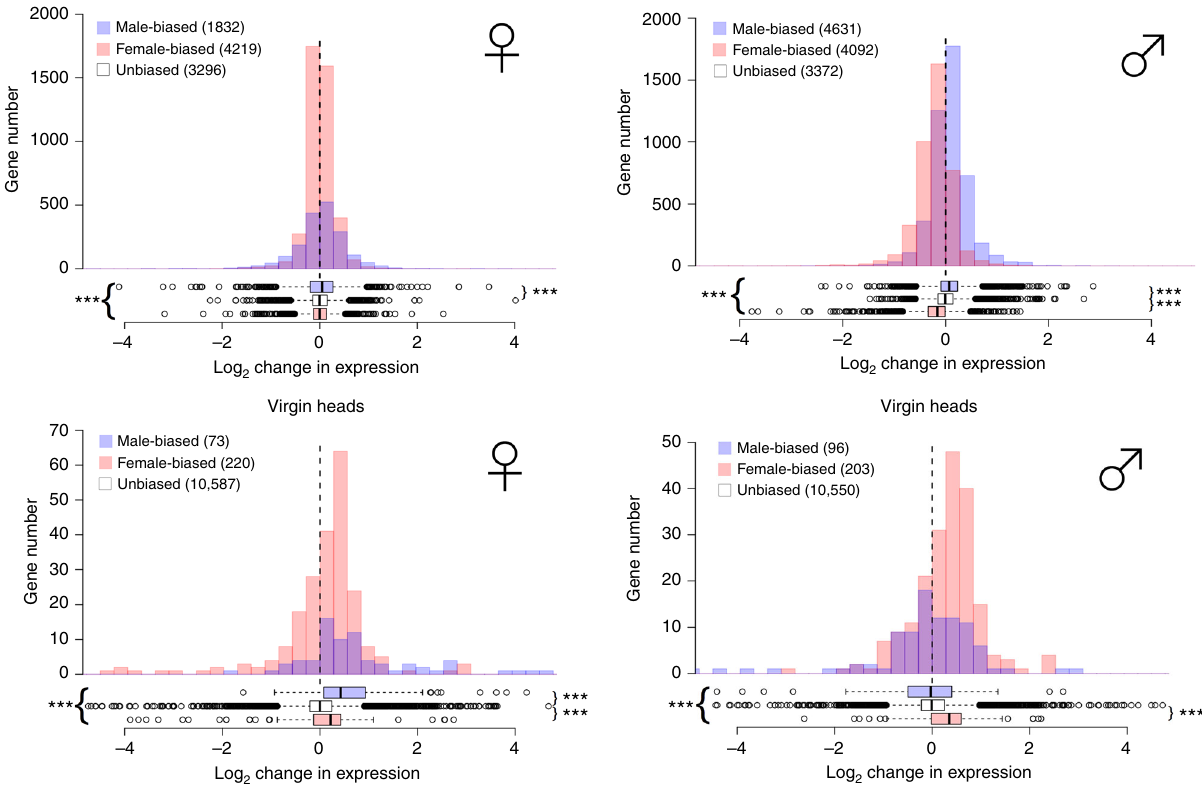
Fig. 1 Gene expression changes following experimental mating system manipulation in virgin fl ies. Positive values on the x axis correspond to higher expression under Monogamy, negative values to higher expression under increased Polyandry. Colours indicate male-biased (blue), female-biased (pink) and unbiased (white) genes in abdomens (top) and heads (bottom). For clarity, unbiased genes are omitted from the histogram. The signi fi cance level of Mann – Whitney rank tests on the average level of sex-biased expression is indicated by asterisks (*** < 0.001). Asterisks to the right of the box plots summarise comparisons of male-biased and female-biased genes with unbiased genes, and those to the left between male-biased and female-biased